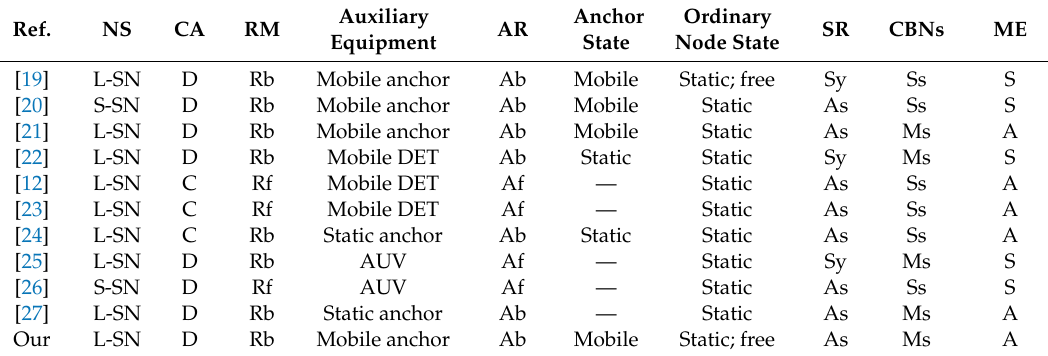
Table 2. Comparison of related underwater Localization